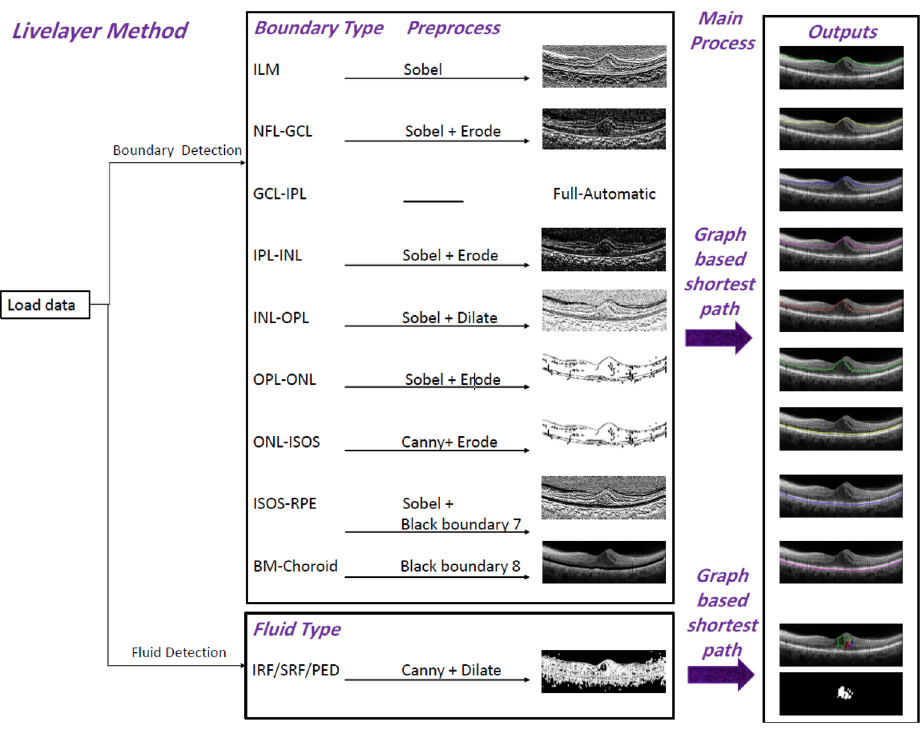
Figure 3. An overview of the Livelayer’s pre-processing block—various operations conducted on each boundary depending on their brightness and location in the